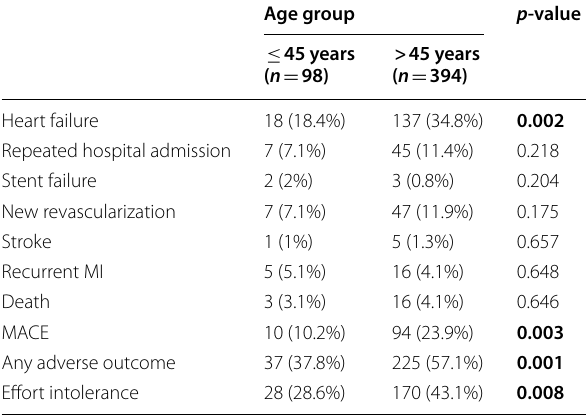
Table 3 Relationship between adverse clinical outcomes and